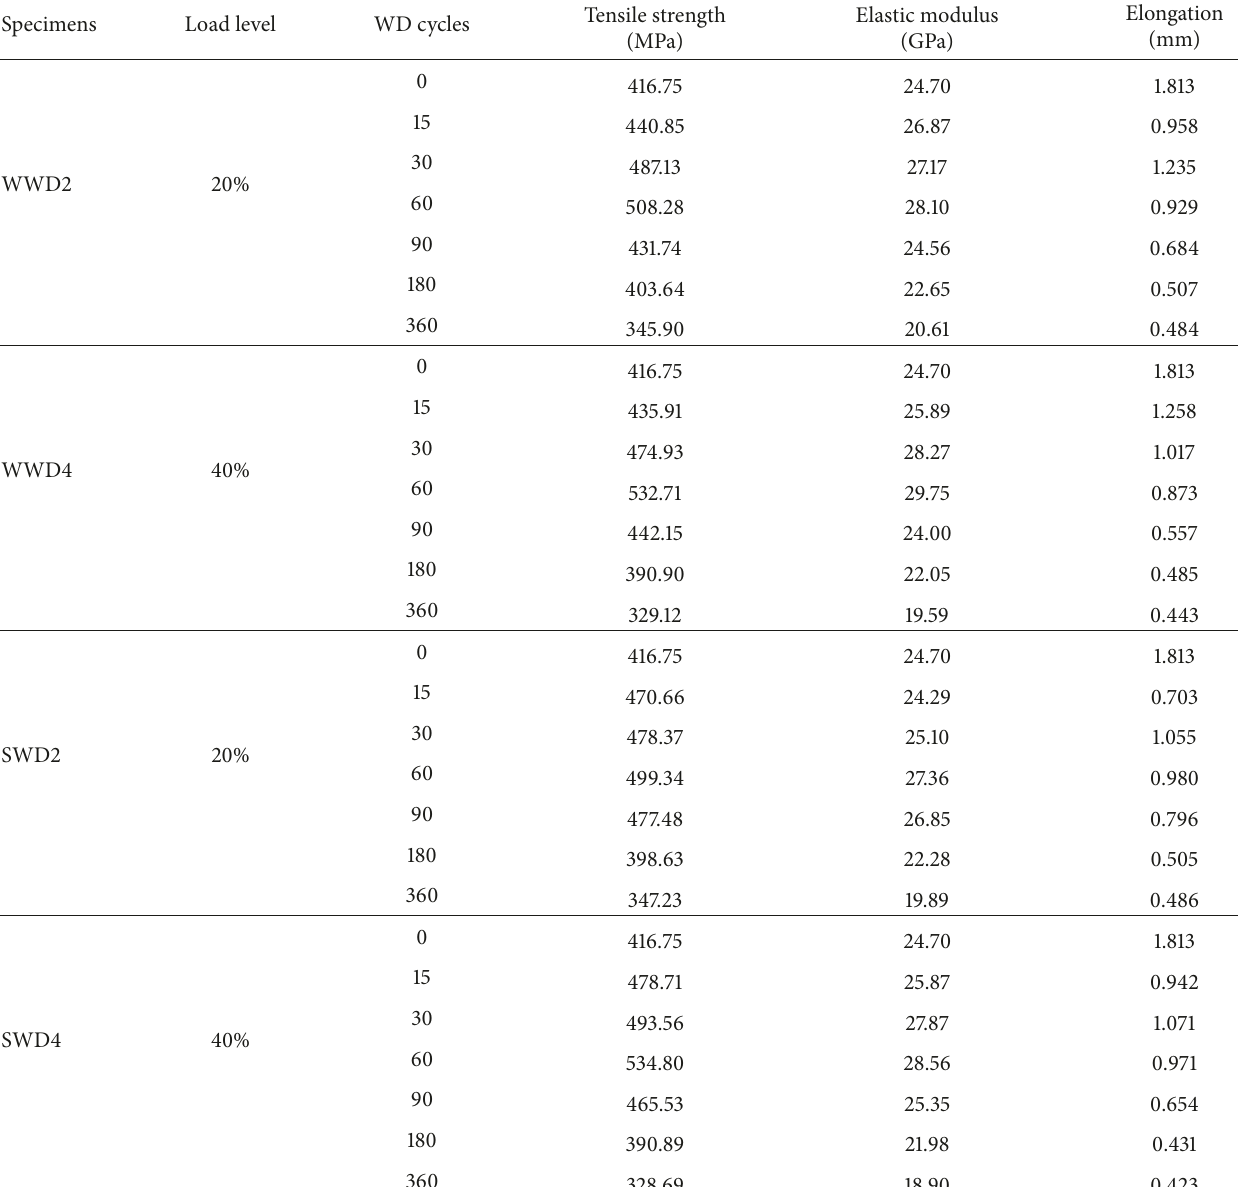
Table 2: Mechanical properties of GFRP under the combined effects of sustained loads and WD cycles.